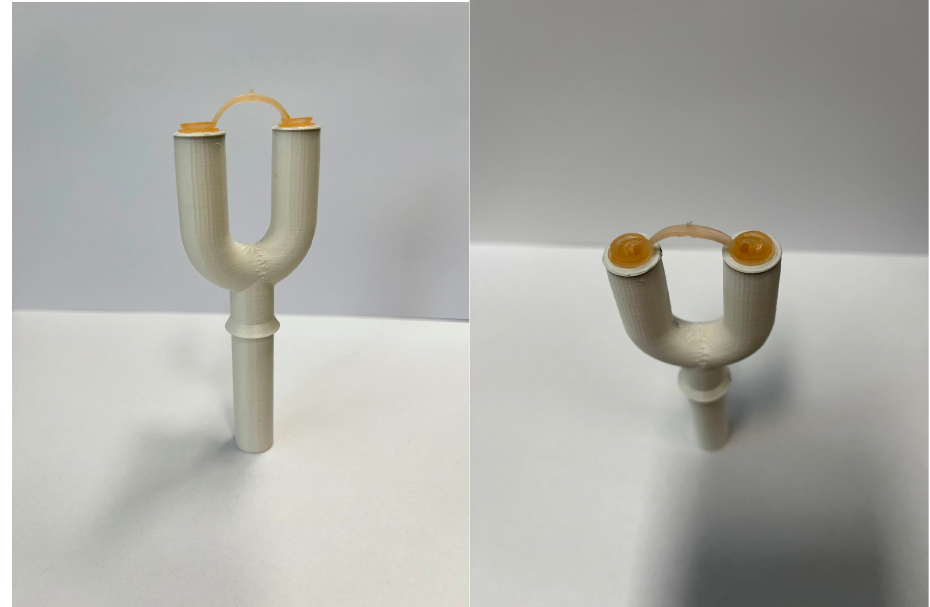
Figure 3. Photographic images of the Y shaped tube sampling port with endonasal filters.